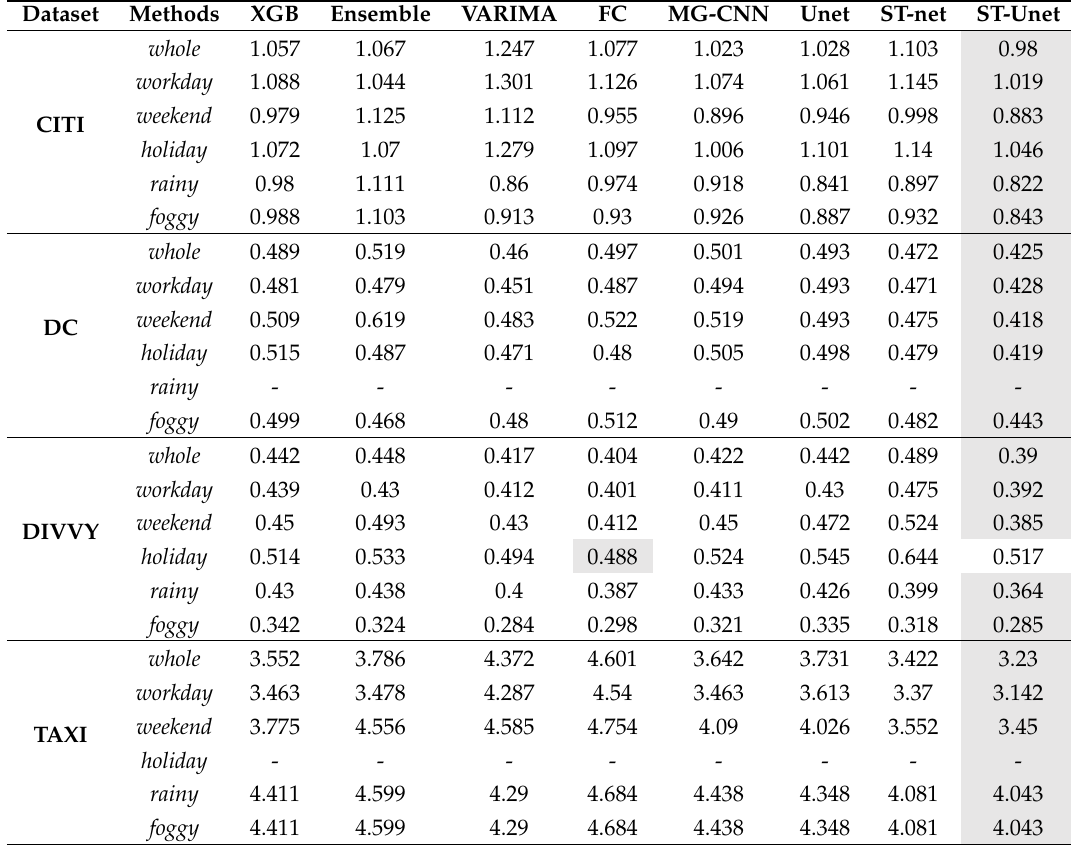
Table 3. Station-level crowd forecasting error of ST-Unet compared with the